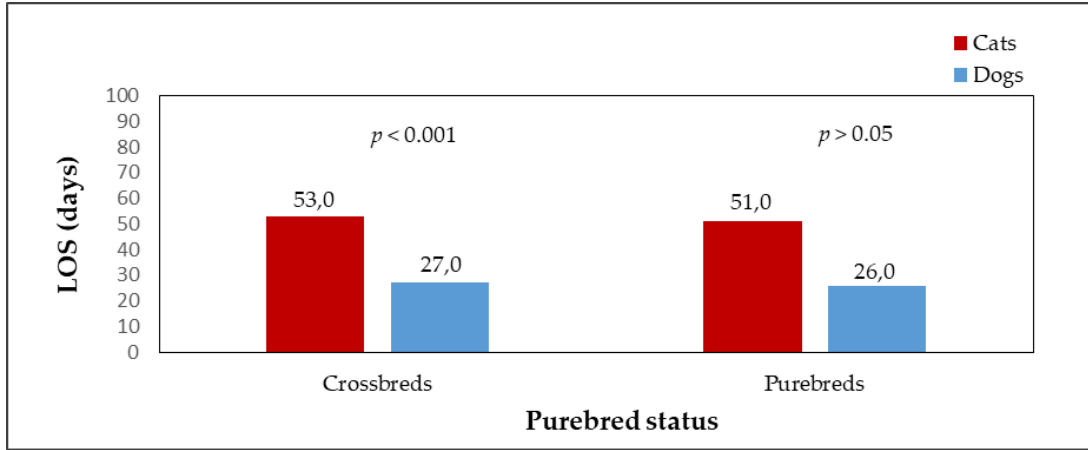
Figure 5. The percentage of adopted dogs (n = 1072) and cats (n = 367) as affected by purebred status.